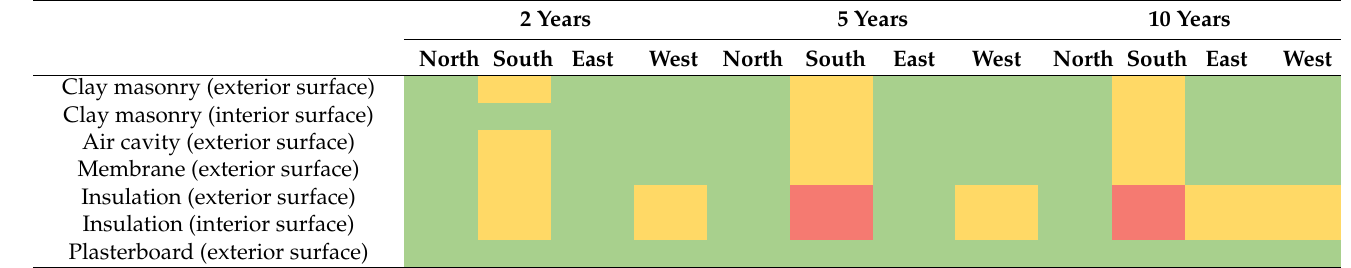
Table 15. Mould growth results of a typical cavity clay masonry veneer wall in all cardinal orientations in CZ